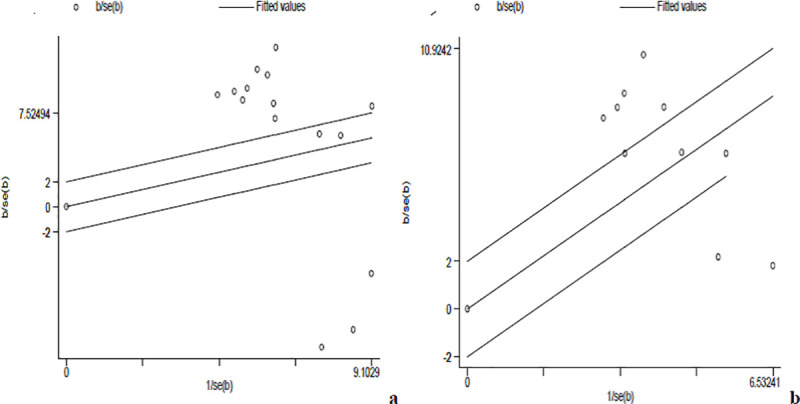
Galbraith plots for seroprevalence of toxoplasmosis in pregnant women (a) and HIV infected (b).